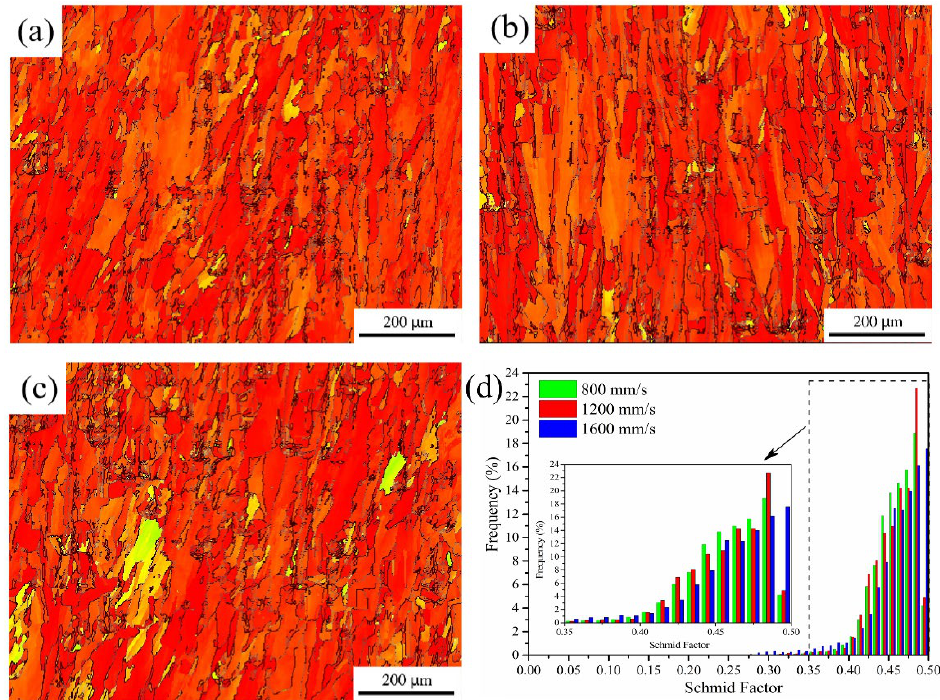
Figure 8. Schmidt factor distribution (( a ) 800 mm/s; ( b ) 1200 mm/s; ( c ) 1600 mm/s) and ( d ) statistical diagram of K418 alloy at different scanning speeds. diagram of K418 alloy at different scanning